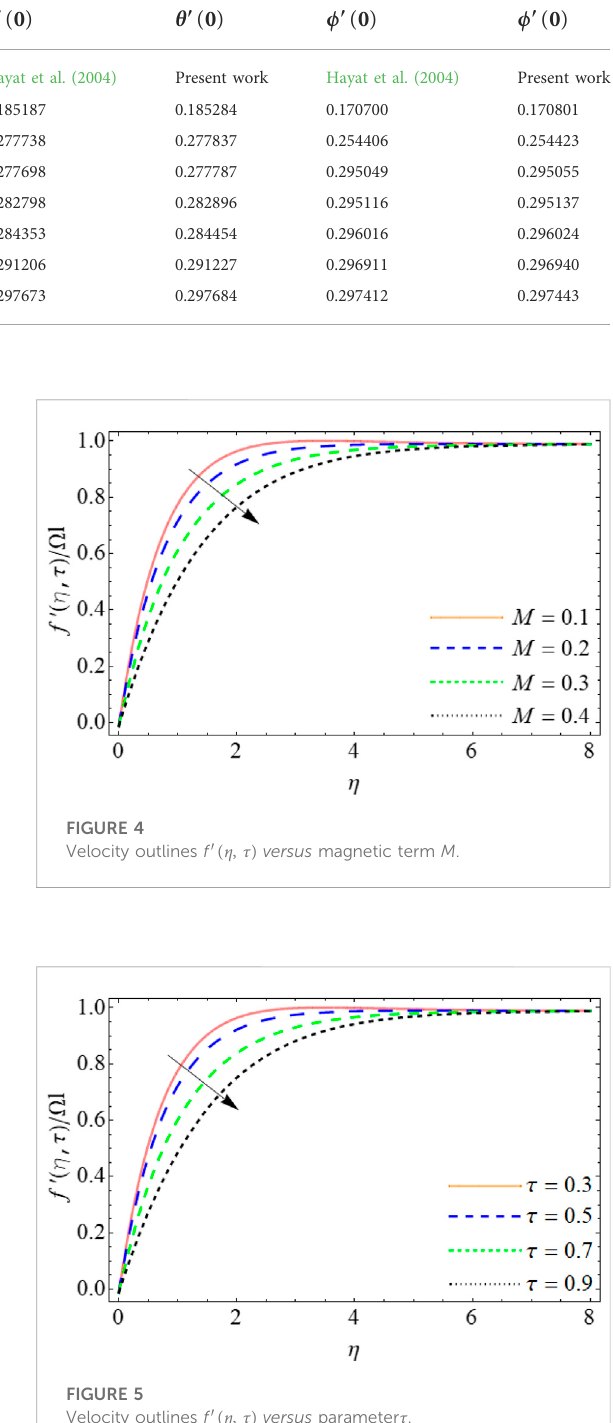
FIGURE 3 Velocity outlines f ′ ( η , τ ) versus Grashof number Gr .